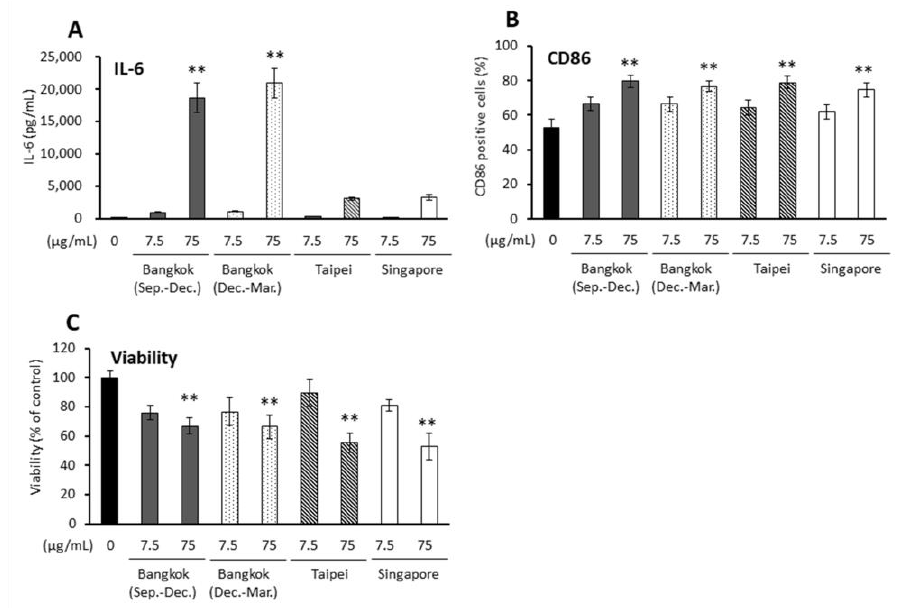
Figure 2. Effects of PM2.5 on proinflammatory responses, CD86 expression, and viability in antigen- presenting cells (APCs). ( A ) IL-6 release, ( B ) CD86 positive cells, ( C ) cell viability. ** p < 0.01 vs. 0 µ